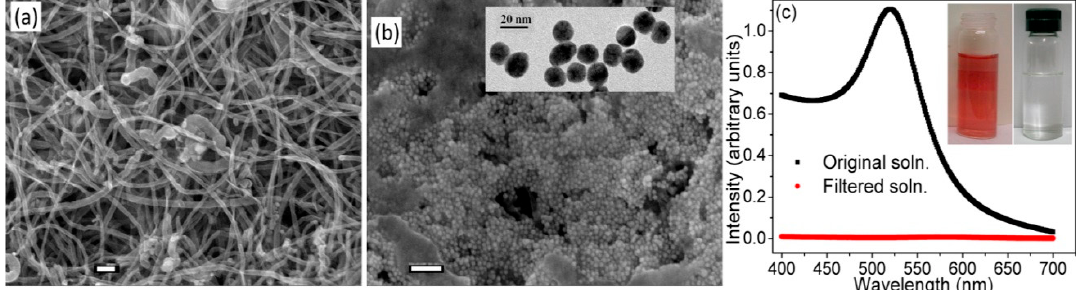
Figure 8. ( a ) SEM micrograph of the surface of a self-supporting MWNT BP prepared from a dispersion of MWNTs in isopropyl alcohol. Scale bar is 100 nm; ( b ) SEM micrograph of the surface of the BP after filtration of gold NPs. Scale bar is 100 nm. The inset is an high-resolution transmission electron microscopy (HRTEM) image showing the Au NPs; ( c ) UV–visible absorption spectrum of the colloidal solution of Au NPs before and after filtration through a MWNT BP. Reprinted with permission from Reference [85]. Copyright American Chemical Society, 2012.